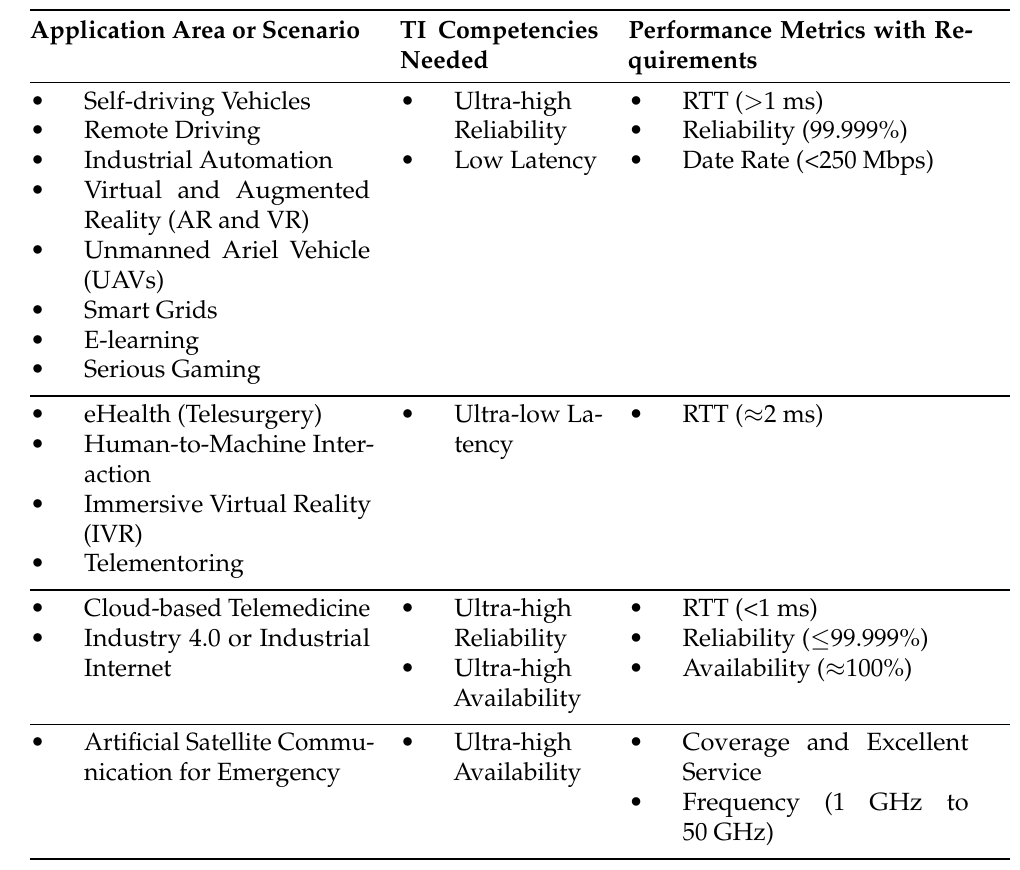
Table 1. Possible applications of the TI with 5G framework and their